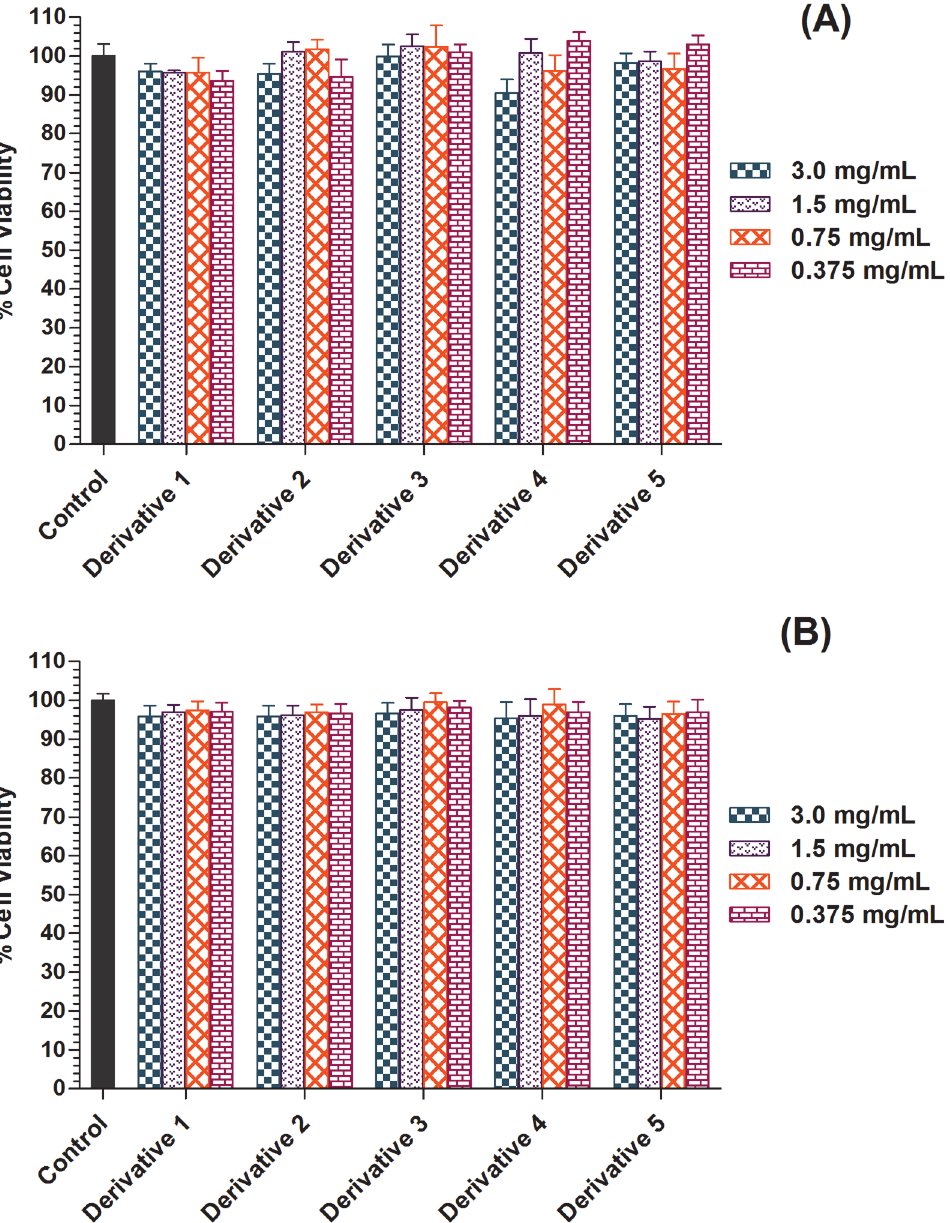
Fig 9. Cell viability of chitosan and derivatives. Figure showing the cell viability effects of chitosan and derivatives on (A) Chinese hamster lung fibroblast cell line V79 and (B) Human hepatic cell line WRL68. Data was presented asmean ± SD (n = 3).